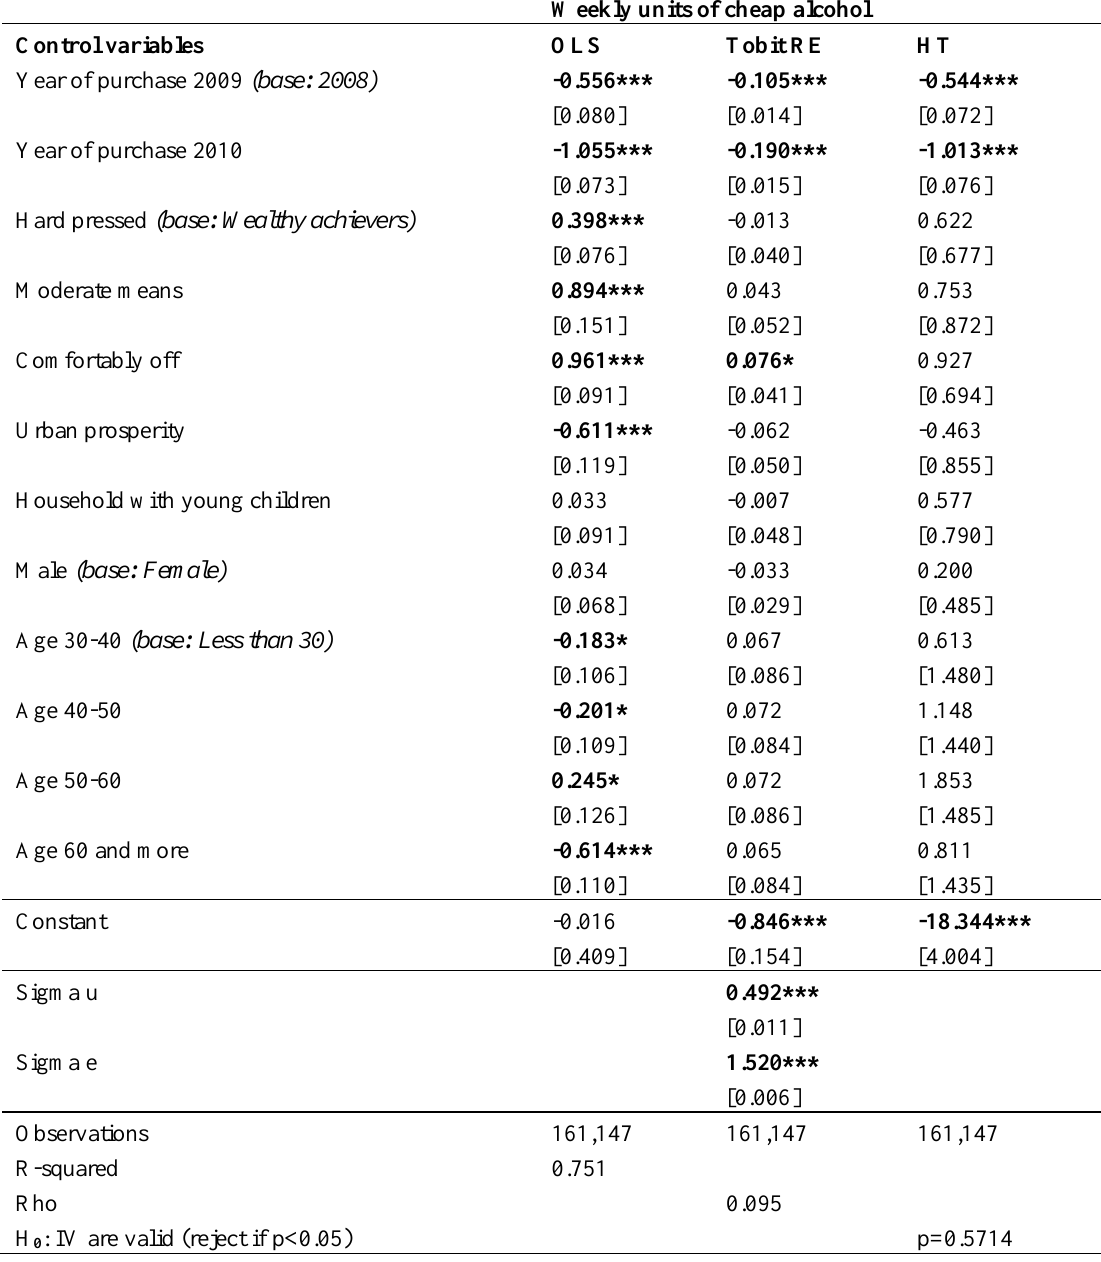
Table 3: OLS, Tobit RE and Hausman-Taylor (HT) regressions for units of cheap alcohol purchased (continued) Weekly units of cheap alcohol Control variables OLS Year of purchase 2009 (base: